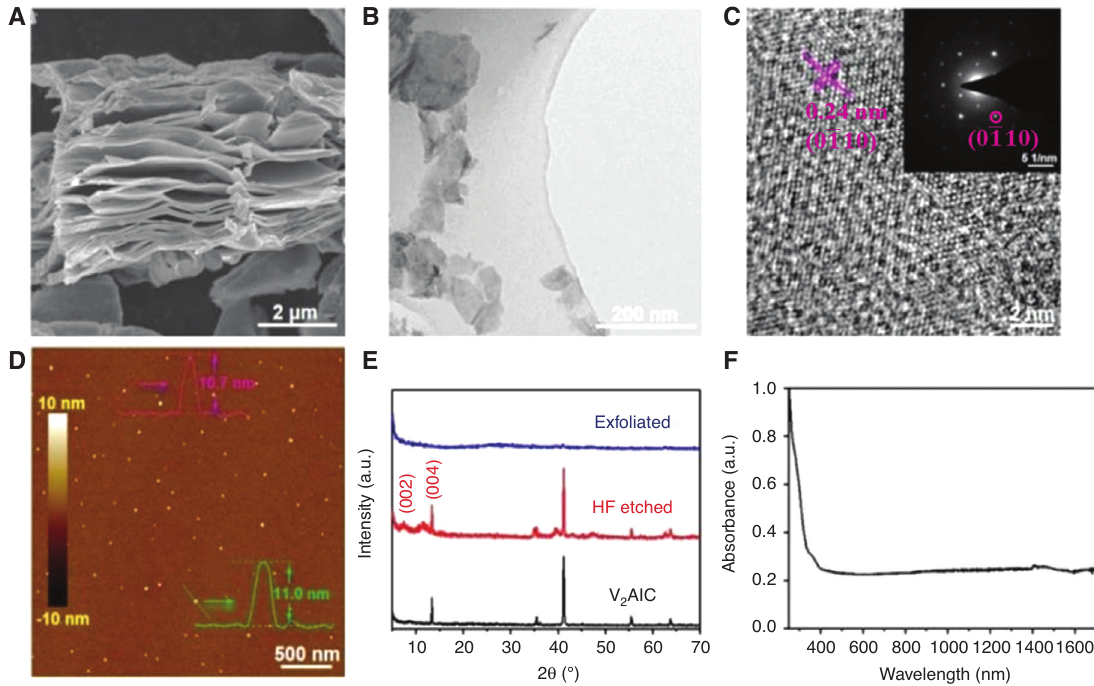
CT ). 2 x CT nanosheets. (D) Atomic force microscopic image of exfoliated V 2 x AlC, etched V AlC, and exfoliated V CT nanosheets. (F) Ultraviolet-visible-near infrared spectroscopy of 2 2 2 x